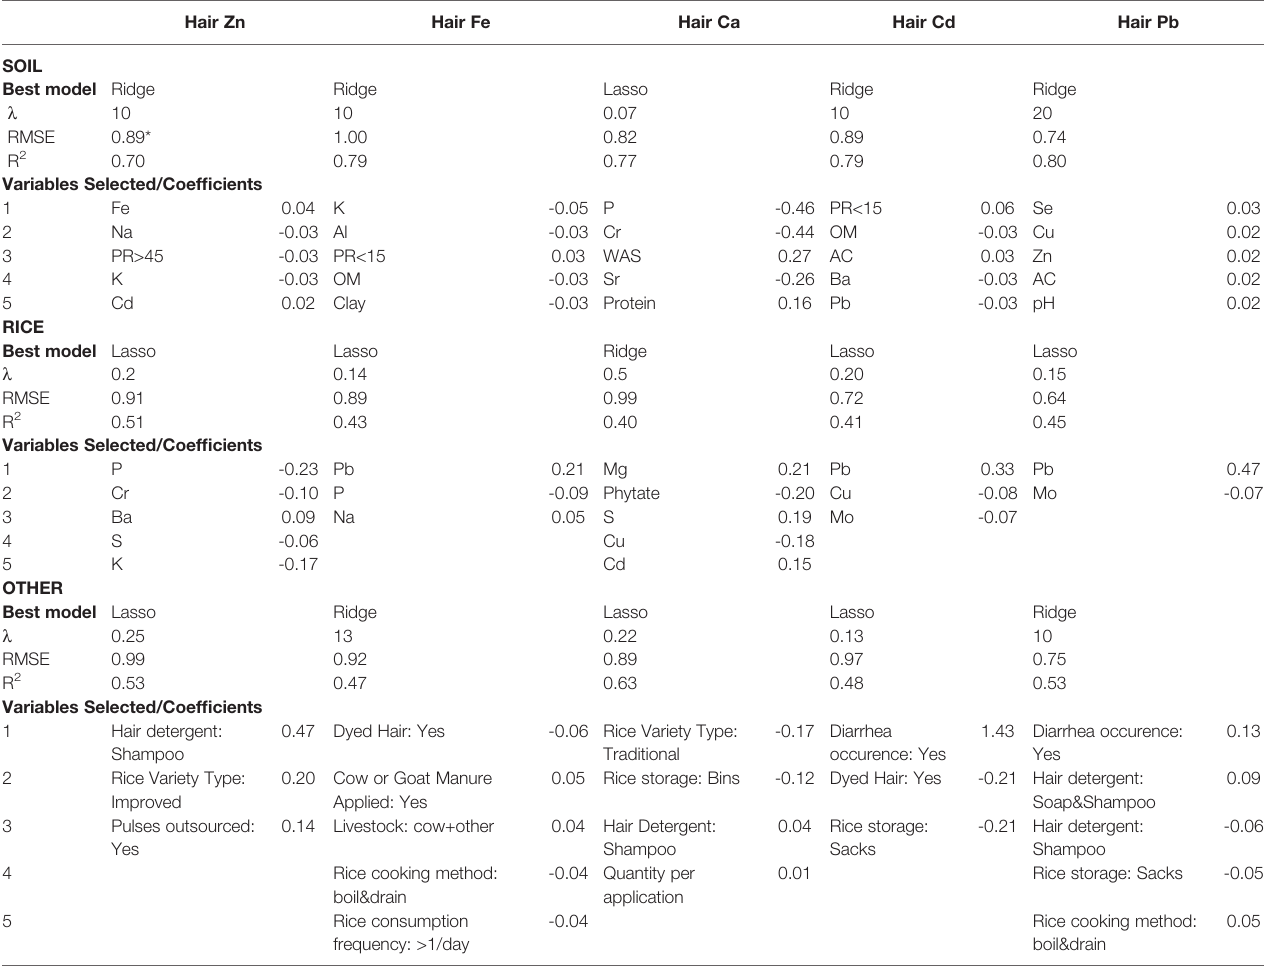
TABLE 2 | The top fi ve predictors in descending order of magnitude (1 ─ 5) of human hair Zn, Fe, Ca, Pb and Cd based on the best model comparison between the ridge and lasso regularized regression methods (data without outliers); l signi fi es the penalty term where higher values indicate more underestimated coef fi cients. Hair Zn Hair Fe Hair Ca Hair